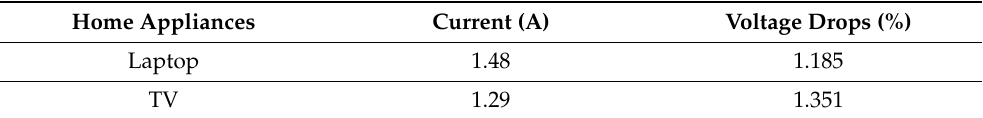
Table 3. LVAC voltage drops.